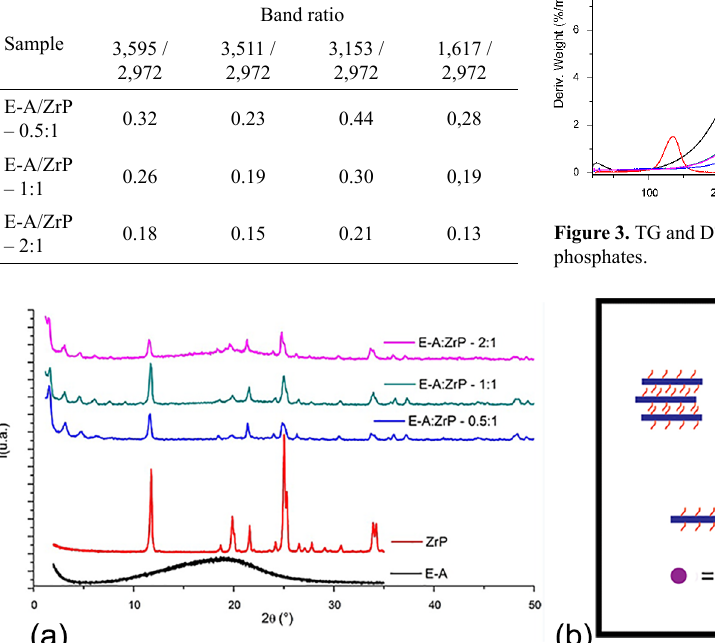
Figure 2. (a) WAXD diffractograms of the ZrP and modified zirconium phosphates, and (b) Schematic representation of the E-A oligomer insertion into ZrP galleries.